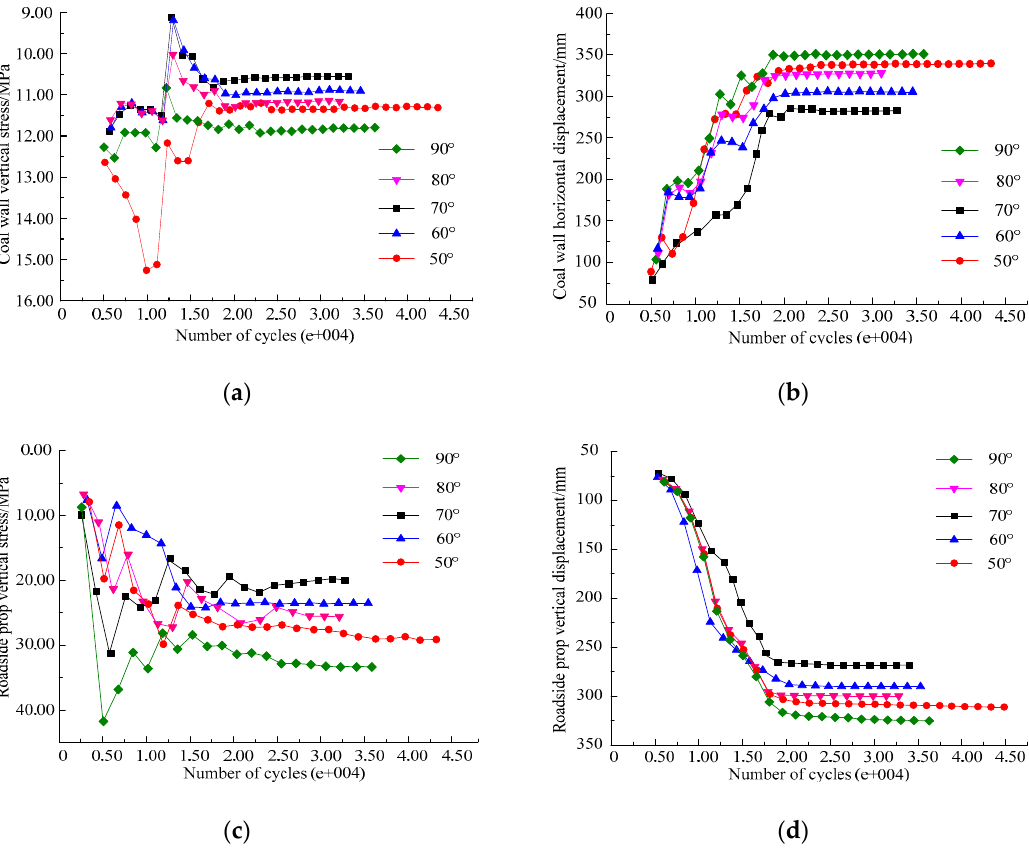
Figure 12. Monitoring points curves after excavation for different cutting angles. ( a ) Coal wall vertical stress; ( b ) Coal wall horizontal displacement; ( c ) Roadside prop vertical stress; ( d ) Roadside prop vertical displacement.